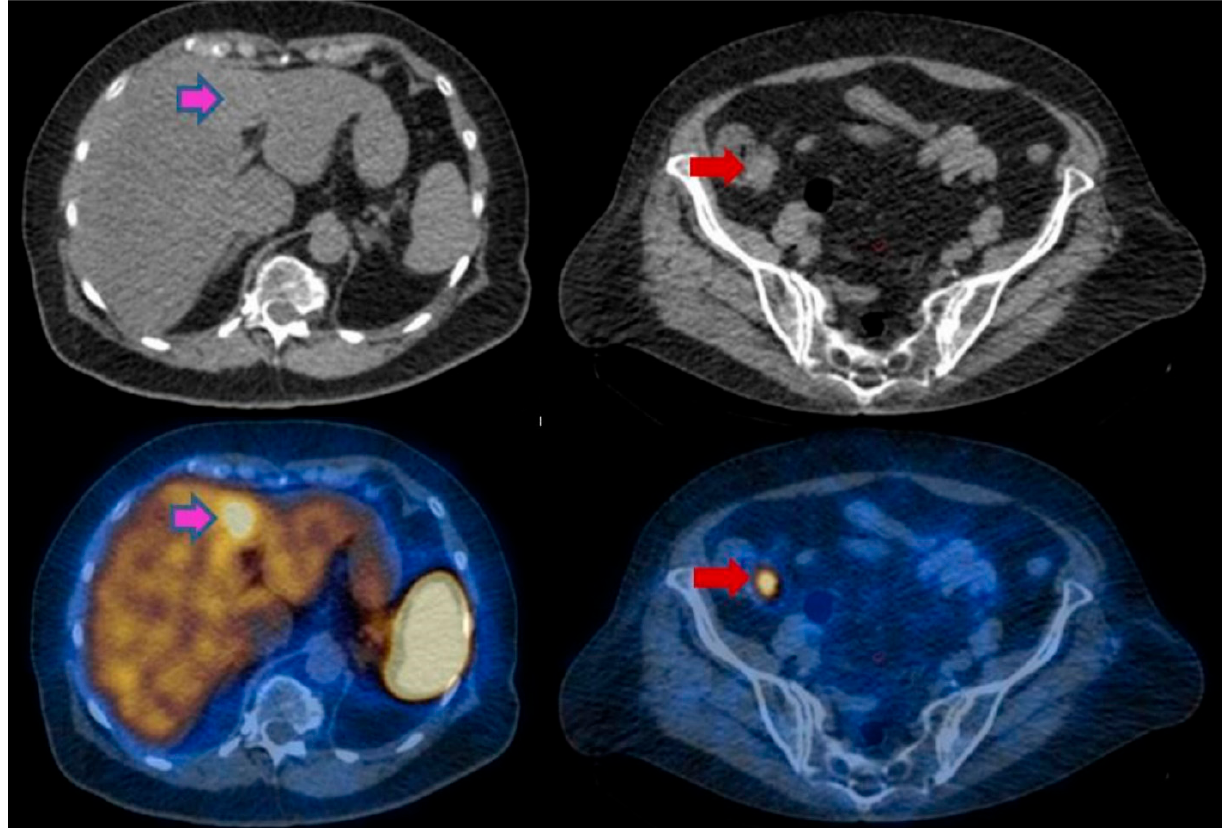
Figure 1. A 71-year-old female patient, diagnosed with a hepatic metastasis of neuroendocrine tumor of unknown origin (confirmed by biopsy, NET G1). The SPECT/CT images show the presence of the hepatic lesion (pink arrows), also showcasing the primary tumor in the ileum (red arrow). The histopathological exam performed after surgical excision of the mass confirmed the presence of a neuroendocrine